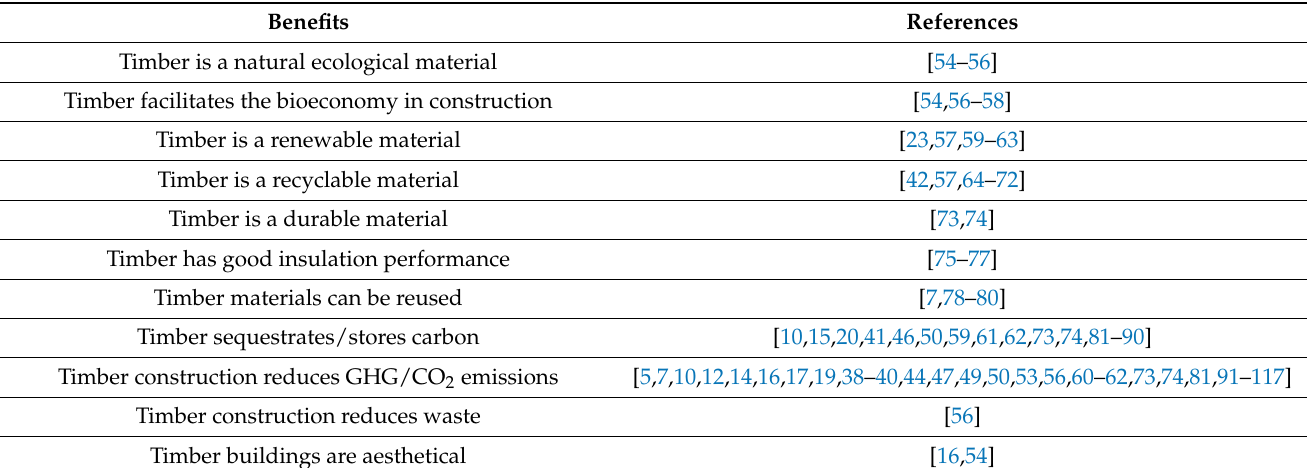
Table 4. Benefits of timber as a sustainable